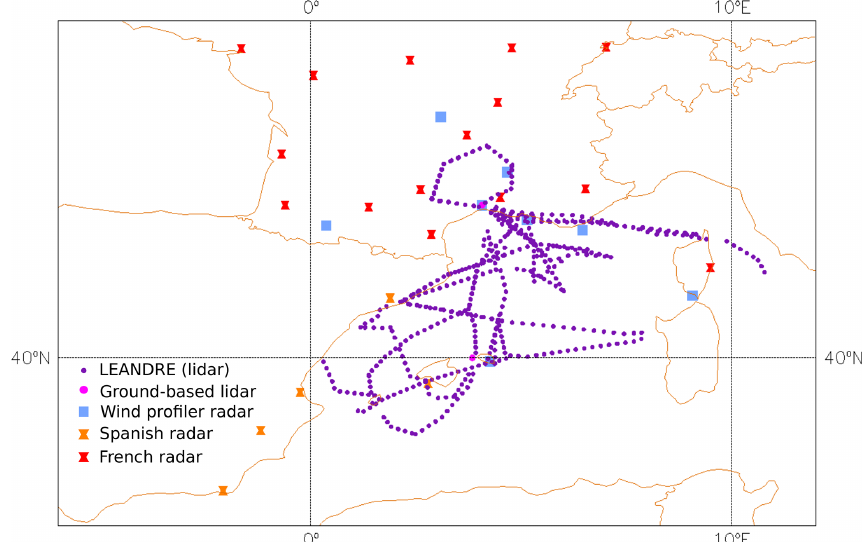
Figure 1. Location of observations considered in this study, with the exception of GNSS zenithal total delays. Wind profilers are depicted with blue squares; ground-based lidars are depicted with pink dots; assimilated LEANDRE II (Lidar Embarqué pour l’étude des Aérosols, Nuage, Dynamique, Rayonnement et Espèces minoritaires) airborne profiles are depicted with purple dots; and Spanish radars are depicted with orange symbols. Red symbols correspond to the French radar